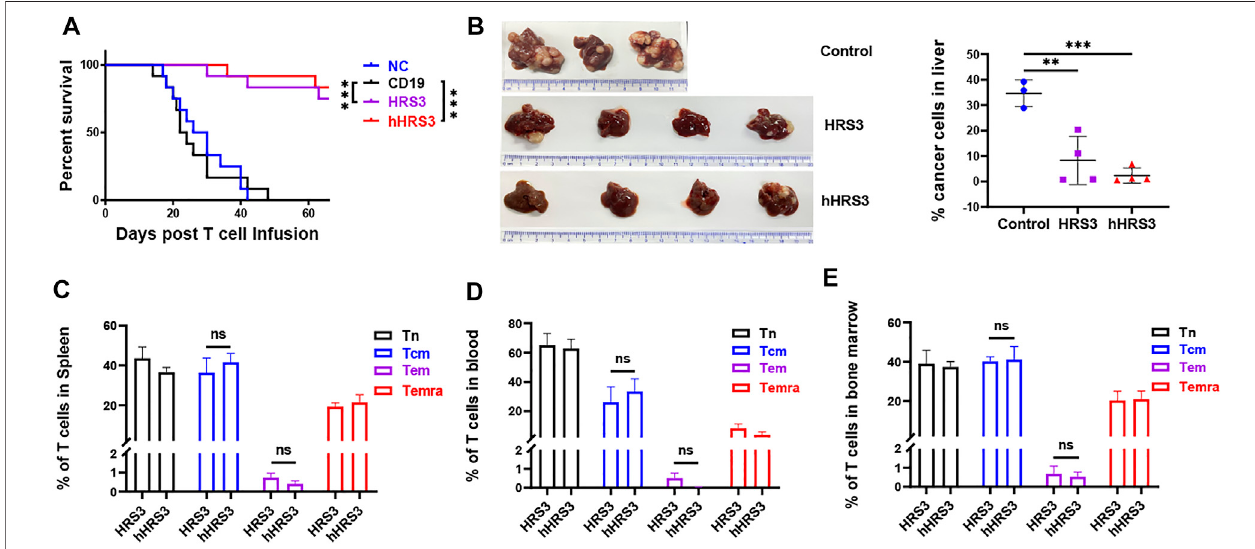
FIGURE5| Centralmemorycells(Tcm)expressinghHRS3-CARwereenriched inmiceand conferredlong-lastingimmunitytoHL. (A) Survivalofmice isshownas a Kaplan-Meier curve (data shown combined from two independent experiments, n (cid:1) 12/group). Survival was not statistically different for NC mice versus CD19; p (cid:1) 0.8037. p < 0.0001 for the comparison of HRS3 group versus CD19 mice. p < 0.0001 for the comparison of hHRS3 group versus CD19 mice. NC, non-transduced T cells. (B) Flow cytometry detection of tumor cell involvement in the liver of mice in each group. The control group was CD19 group ( n (cid:1) 3), and the experimental groupwasHRS3andhHRS3groups( n (cid:1) 4). (C) Spleen, (D) blood,and (E) bonemarrowfromsurvivingCD30-CAR-treatedmice( n (cid:1) 3)wereanalysedforthenumberof CAR-T cell subsets using fl ow cytometry (mean ± SD). T cells are functionally divided into four subsets: naïve (CCR7 + CD45RO − ); central memory (CCR7 + CD45RO + ); effectormemory(CCR7 − CD45RO + );andterminaleffector(CCR7 − CD45RO −